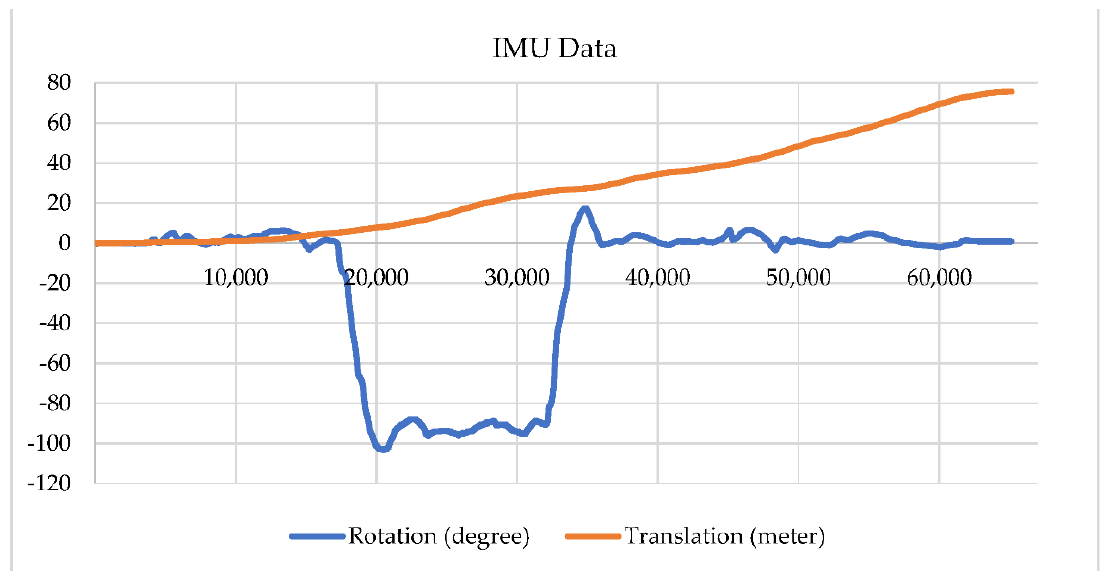
Figure 16. IMU data recorded on the tour of Test#4.